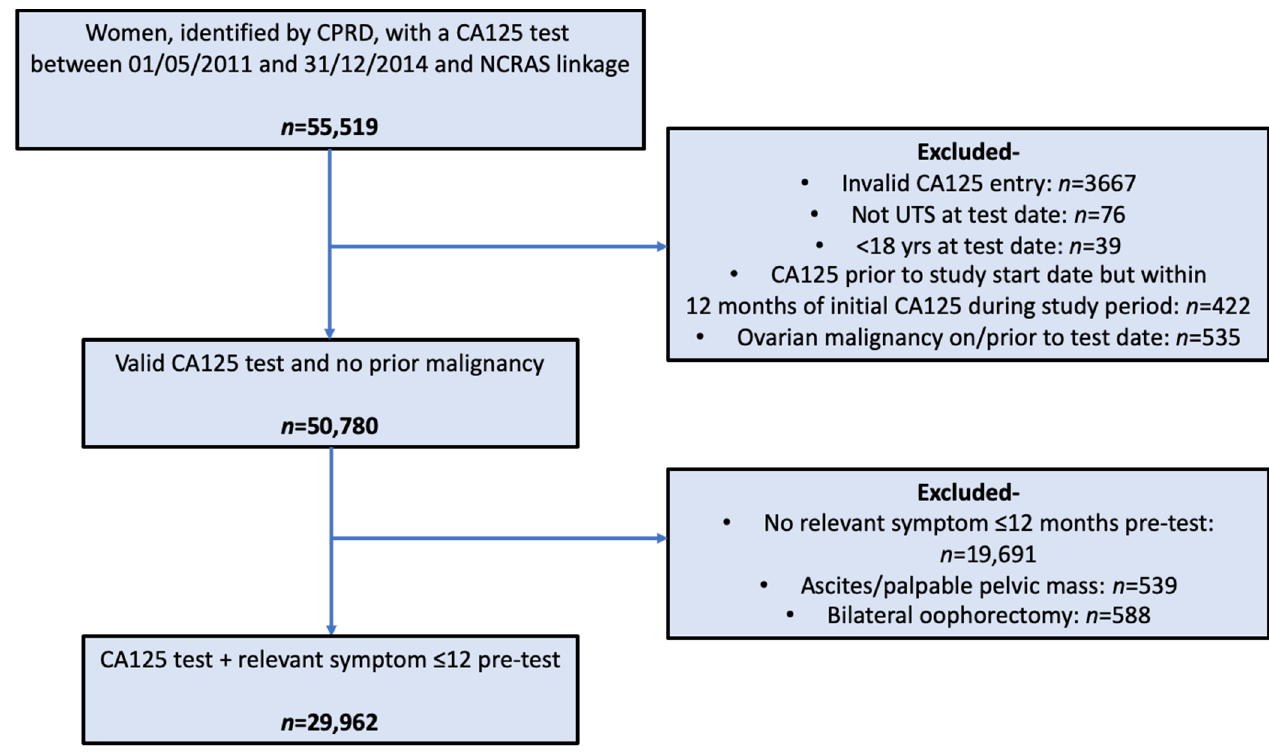
Figure 1. Application of study criteria. “Invalid CA125 entry” = no CA125 value, no or incorrect units, and no upper threshold or spurious upper threshold. Table 2. Cohort baseline